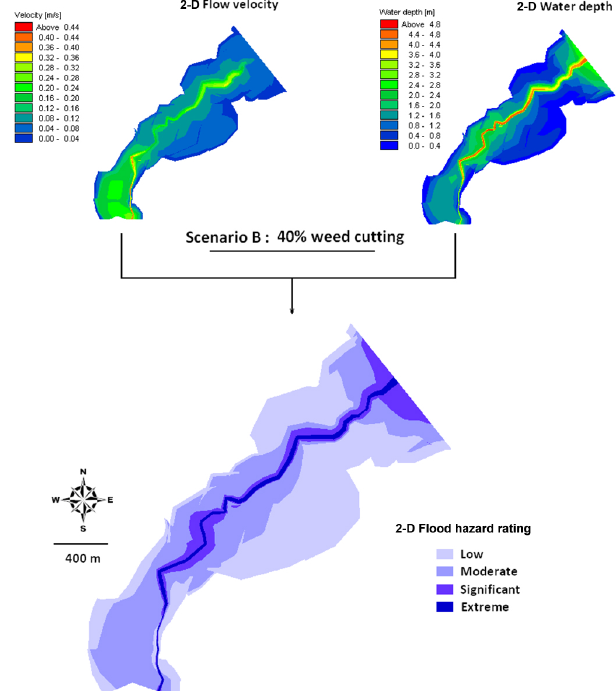
Fig. 4. Flow velocity, flood inundation and flood hazard rating maps for scenario A (no weed cutting).